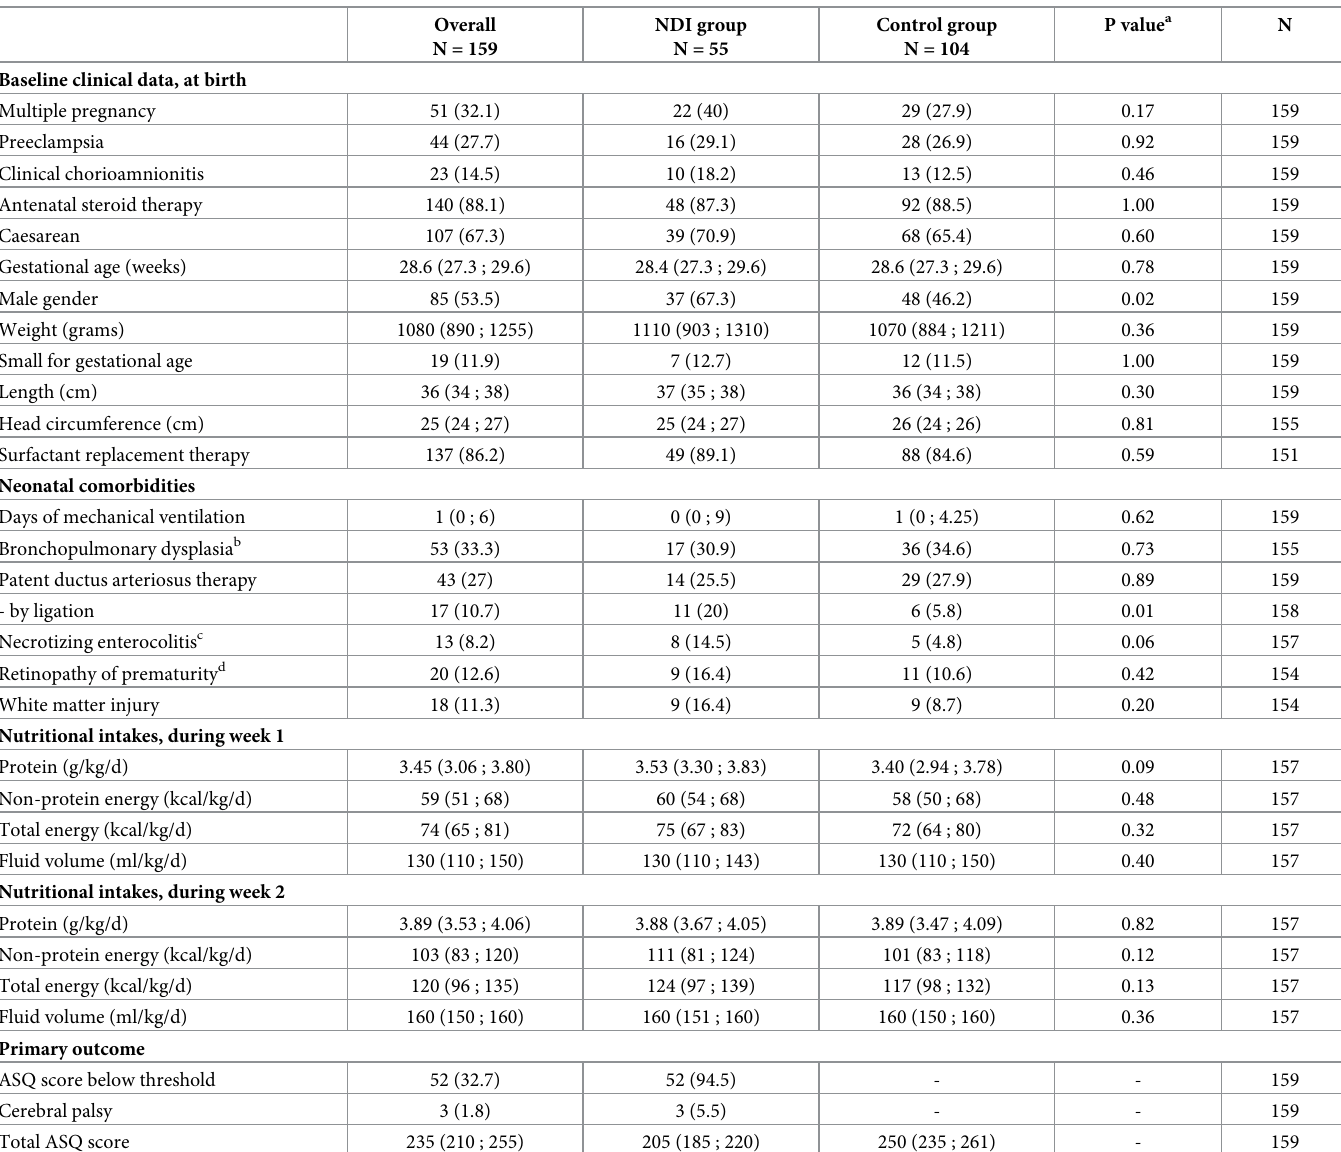
Table 1. Baseline characteristics of the follow-up